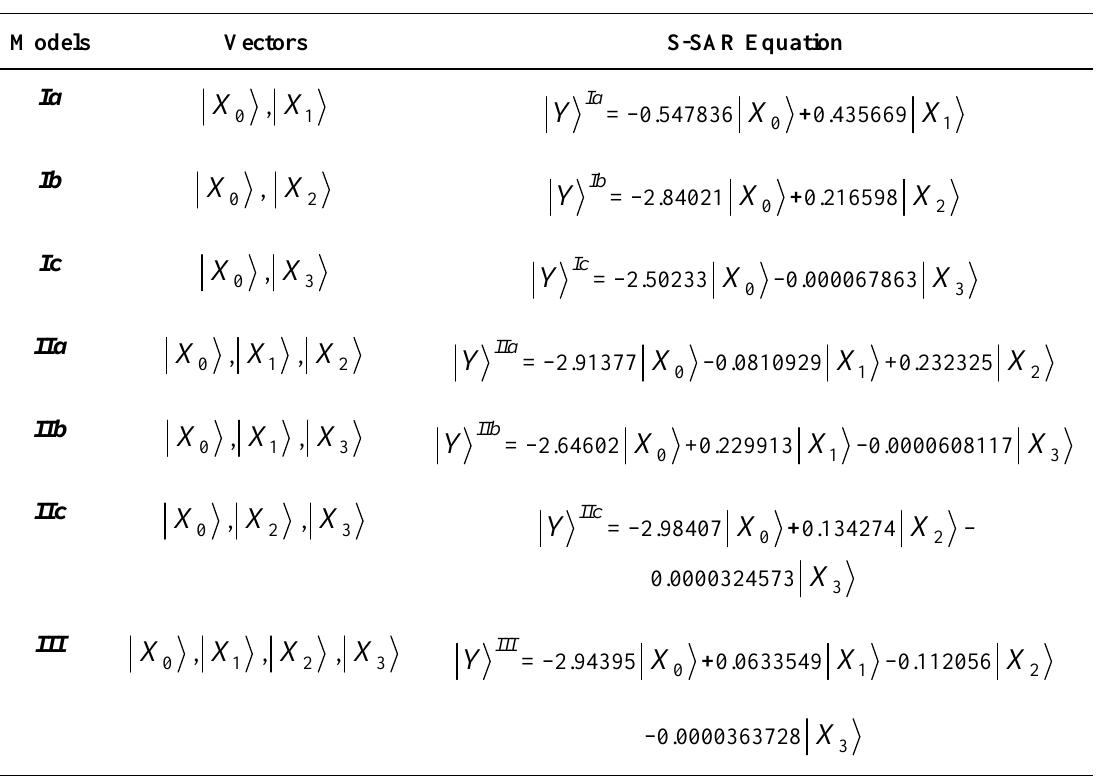
Table 5. Spectral structure activity relationships (S-SAR) through determinants of Equations (27)-(29) for all possible correlation models considered from the data in Table